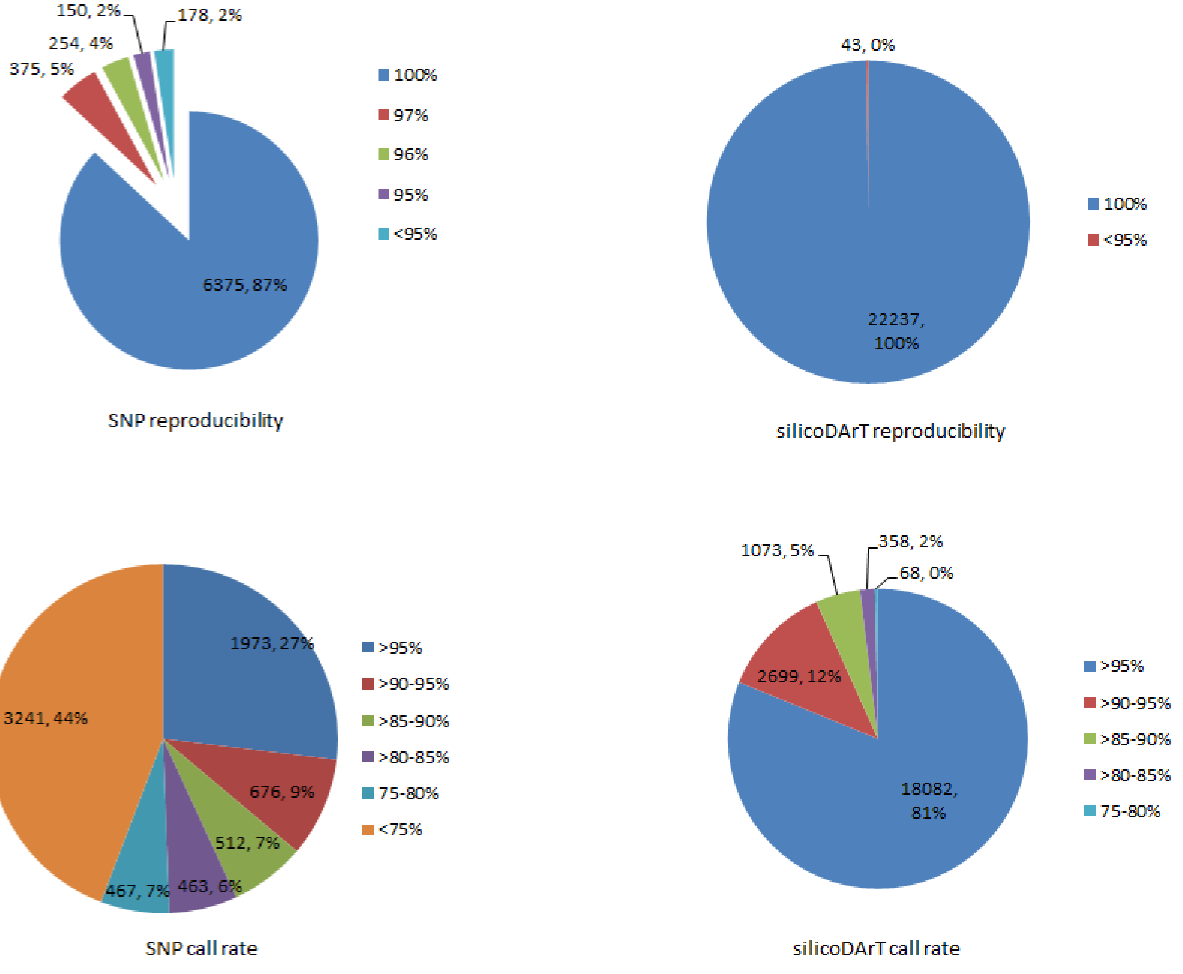
Fig 1. Distribution of silicoDArT and SNP marker data for several quality parameters.